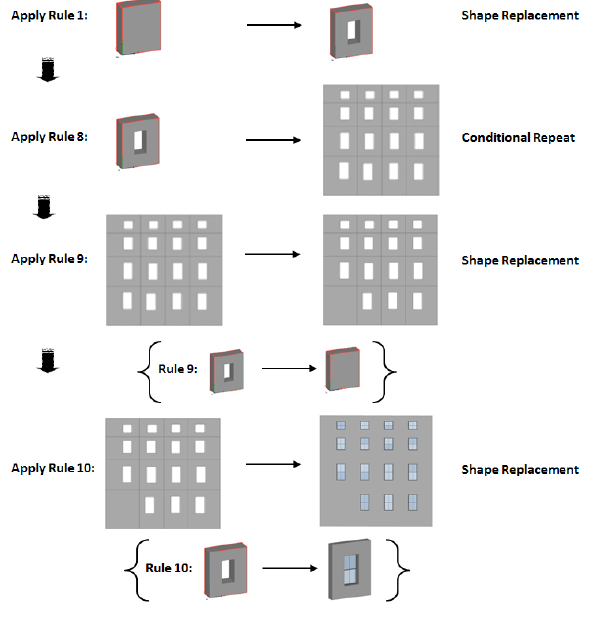
Figure 7. Application of shape rules specified in Table